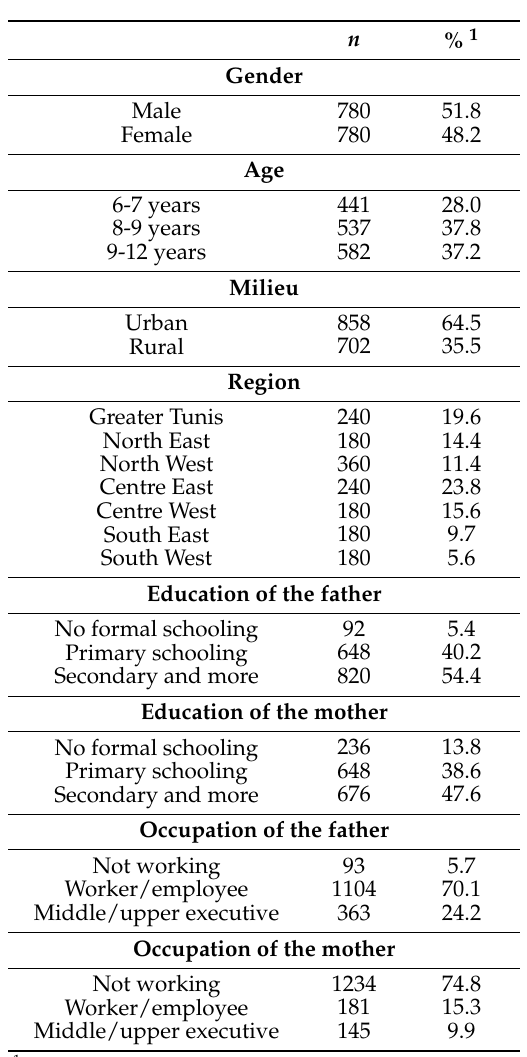
Table 1. Socio-demographic characteristics and place of residence of 6–12-year-old Tunisian school children in 2012 ( n =